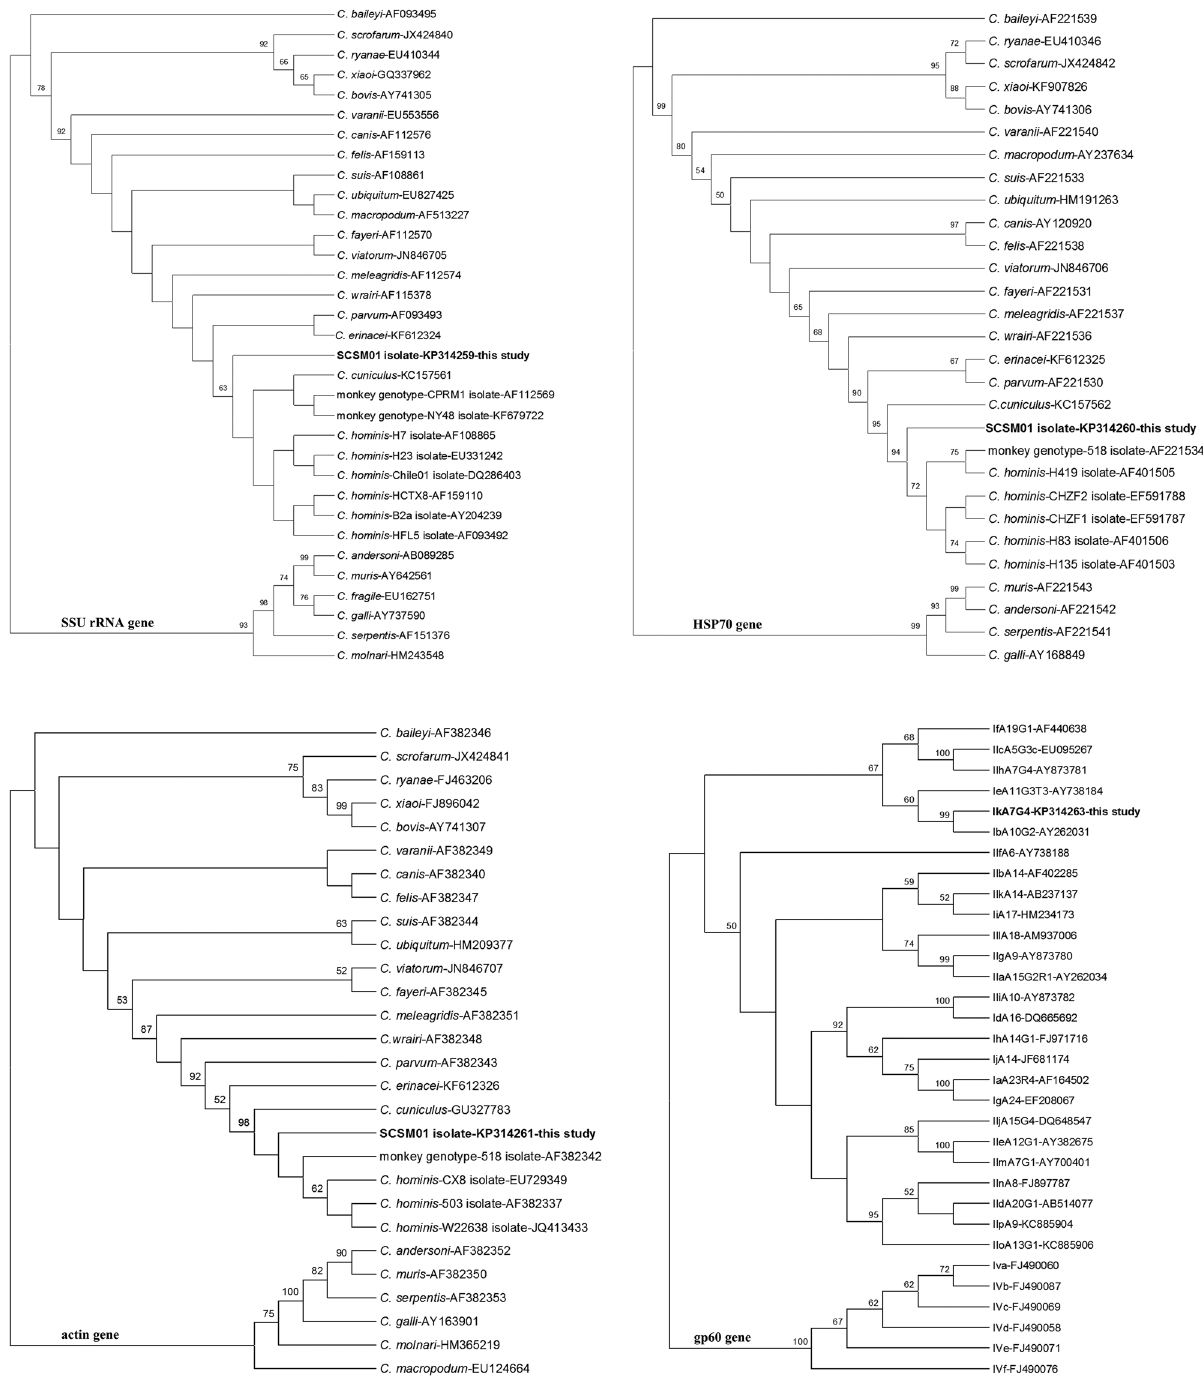
Fig 3. Phylogenetic relationship of the SSU rRNA, HSP70, actin, and gp60 genes sequences of Cryptosporidium squirrel monkey isolate detected in this study to other known Cryptosporidium species/genotype, respectively, as inferred by a maximum likelihood analysis. Bootstrap values were obtained using 1,000 pseudo-replicates and greater than 50% was shown on